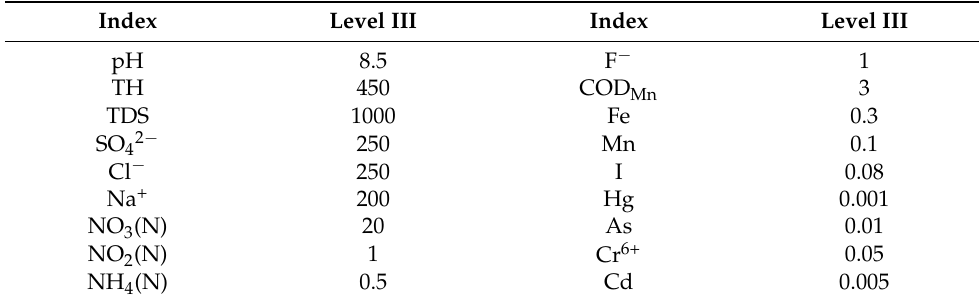
Table 1. Evaluated standard of the main indices of groundwater.